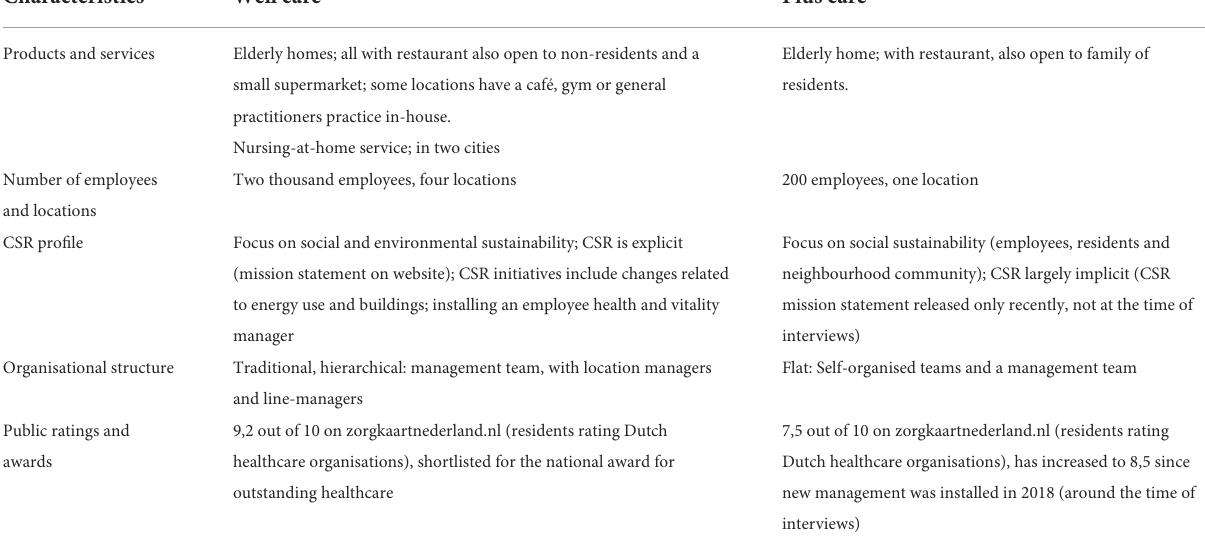
TABLE 1 Summary of major characteristics of case organisations.